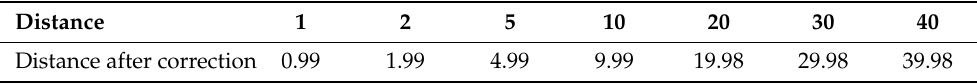
Table 9. The different distance values after correction (unit: m).